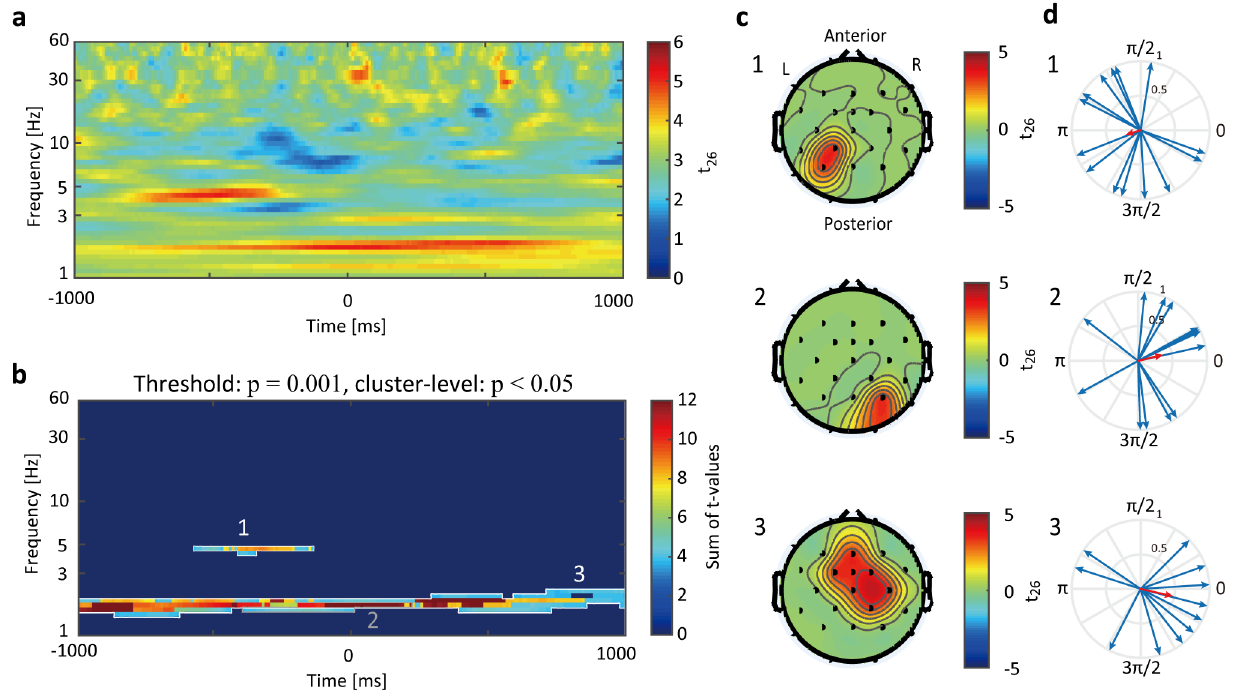
Fig 3. Phase-utility on behavior (PUB) result. (a) Statistical t-map of the comparisonbetweenaveraged PUB across all electrodesand surrogate data. The color bar represents the t-value of the two-sample t-test (n = 14). Larger t-values mean the PUB increasedrelativeto the surrogate. (b) Cluster-level analysisof the PUB and surrogate comparisonbasedon the temporal, spectral, and electrodeadjacency. The three areas indicatedby the numbers 1–3 in the figure are the significantclusters (cluster level p < 0.05). For presentation purposes,the color bar represents the summation of t-values among the electrodes, while the significantclusters were decidedthrough a summation of the temporal, spectral, and electrodes spaces. (c) The scalp topographies show the averaget-values amongthe temporaland spectral spaces of each cluster. The numbers 1–3 corresponded to the cluster numbersin (b). (d) Individual optimal phase(blue arrows) and circular mean among all participants (red arrow; top: CP1 theta; middle: P4 delta; bottom: FC2 delta). The position of time-frequency electrodewas chosen to the show maximal PUB value within each cluster for this circularmean analysis. The Rayleightest for uniformity was appliedin each of the optimal phases (CP1 theta, Z (14) = 0.7207, p > 0.05; P4 delta, Z (14) = 1.9491, p > 0.05; FC2 delta, Z (14) = 3.2771, p < 0.05).